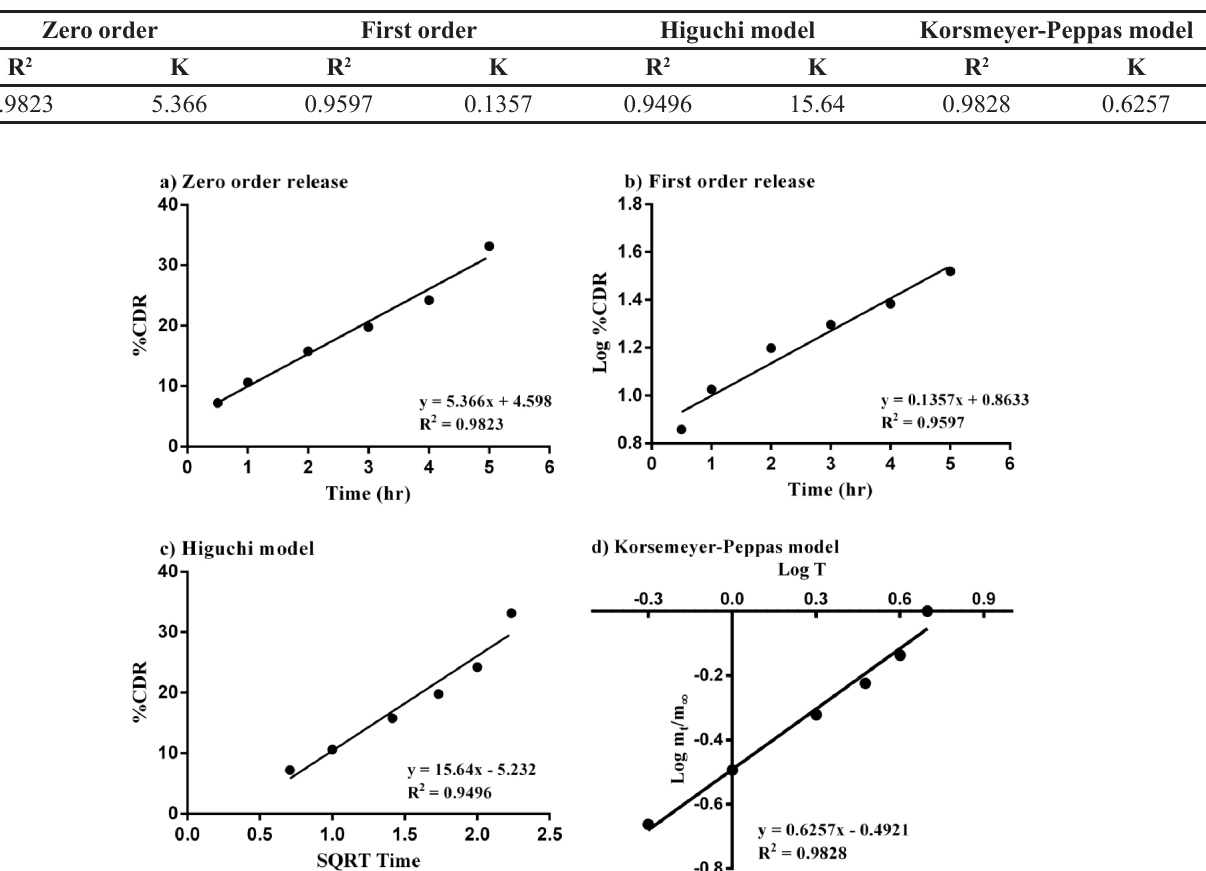
FIGURE 1 - Release profile of irbesartan-loaded SLN F3, (a) zero order, (b) first order, (c) Higuchi model and (d) Korsmeyer- Peppas